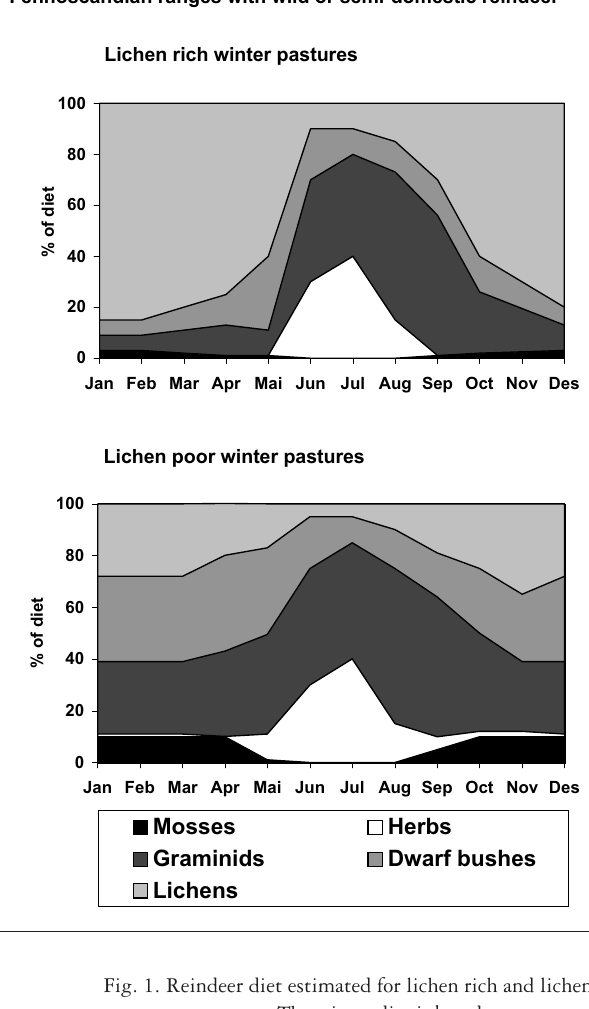
Fig. 1. Reindeer diet estimated for lichen rich and lichen poor ranges. The winter diet is based upon rumen analyses from the following ranges and sources: Snøhetta (Gaare, 1968), Hardangervidda (Gaare & Skogland, 1975), Rondane, Forelhogna and Finnmarksvidda (Gaare, unpubl.). The summer diet is estimated from data by Gaare & Skogland (1975), Skjenneberg et al. (1975), Eriksson et al.